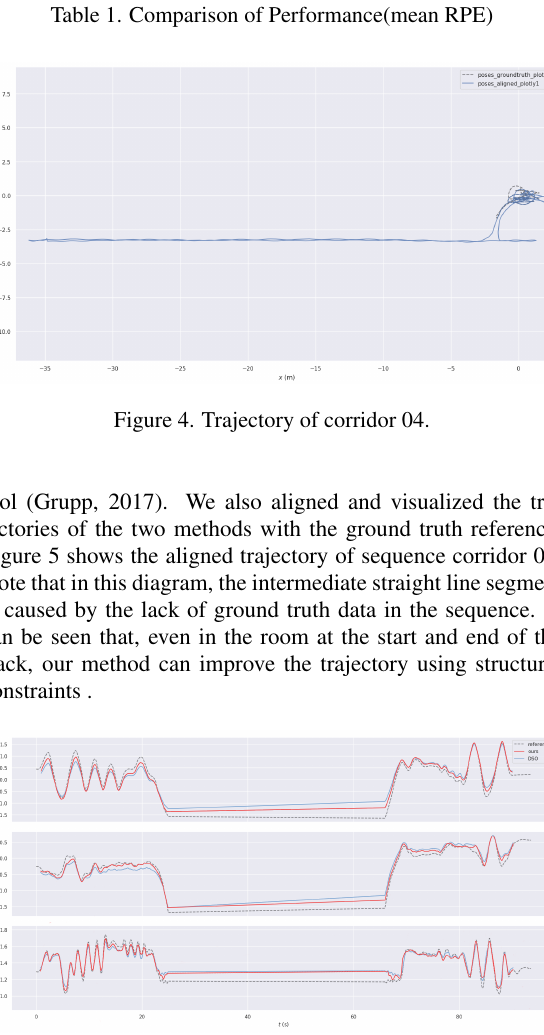
Figure 5. The aligned trajectory of DSO and ours on x, y, z axis